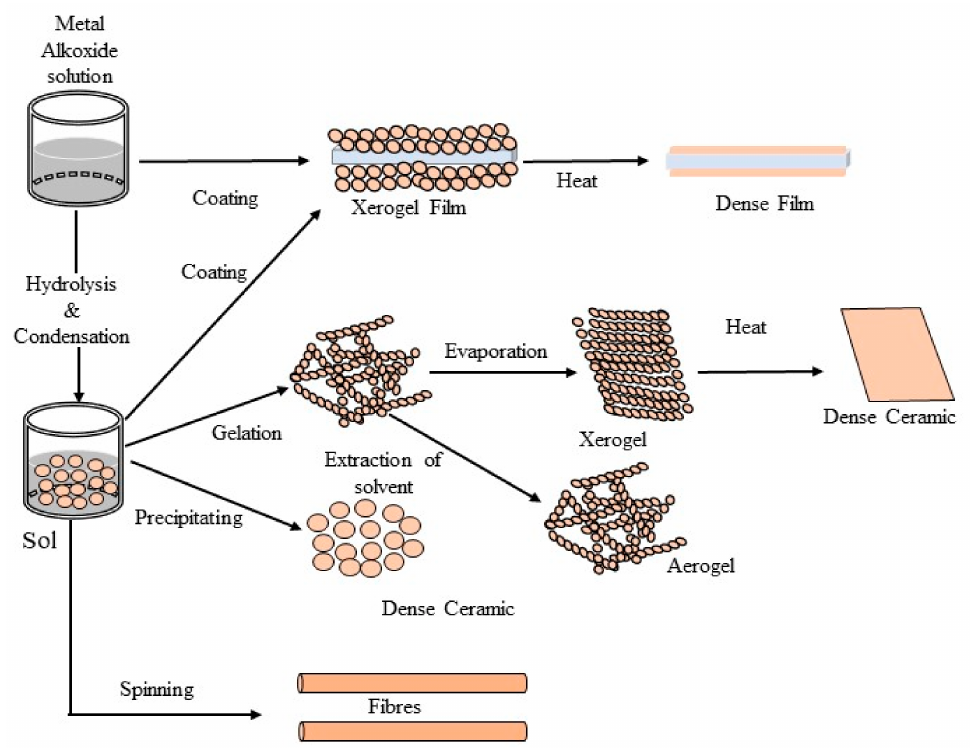
Figure 5. Sol-gel methods for nanoparticle